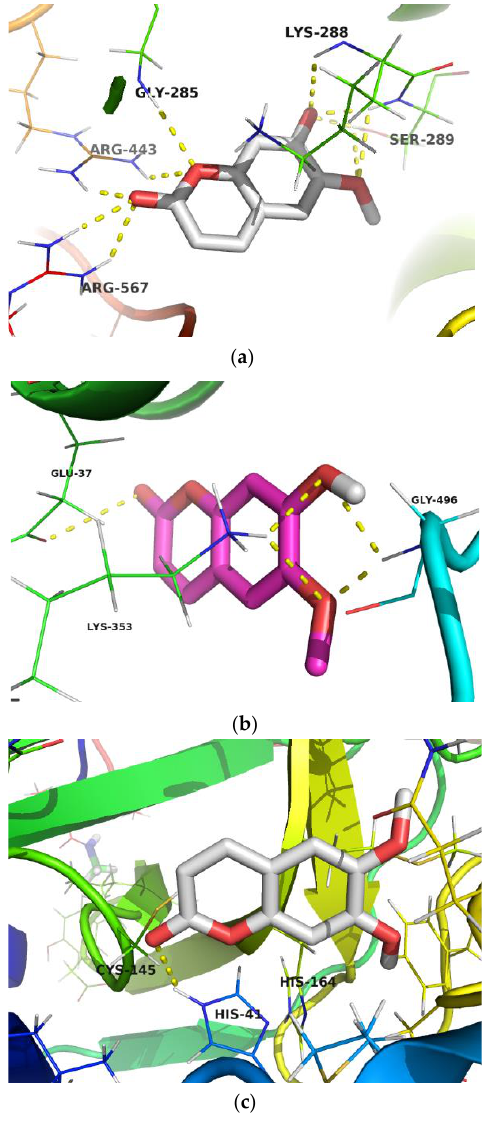
Figure 4. Molecular binding model of scopoletin within the active site of ( a ) the main protease (Mpro, PDB: 5R82); ( b ) within the interface region between the spike RBD (colored cyan) and human ACE2 (colored green), (PDB code: 6M0j); ( c ) within the active site of RNA helicase, nsp13 (PDB code: 5RL9) obtained by AutoDock Vina in PyRx 0.8 (Scripps Research, La Jolla, CA, USA).